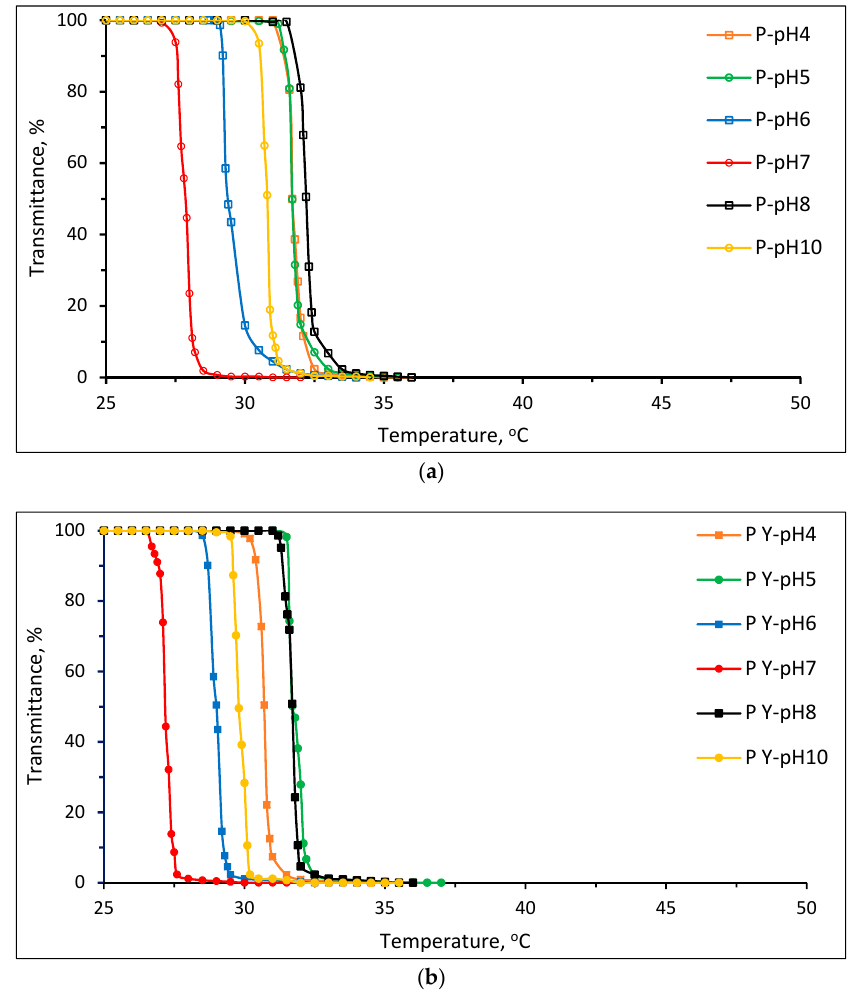
Figure 7. Plots of transmittance vs. temperature of 1 wt % aqueous solutions of Pnipam in buffer solutions of pH = 4~10 synthesized ( a ) without and ( b ) with stereo-control.